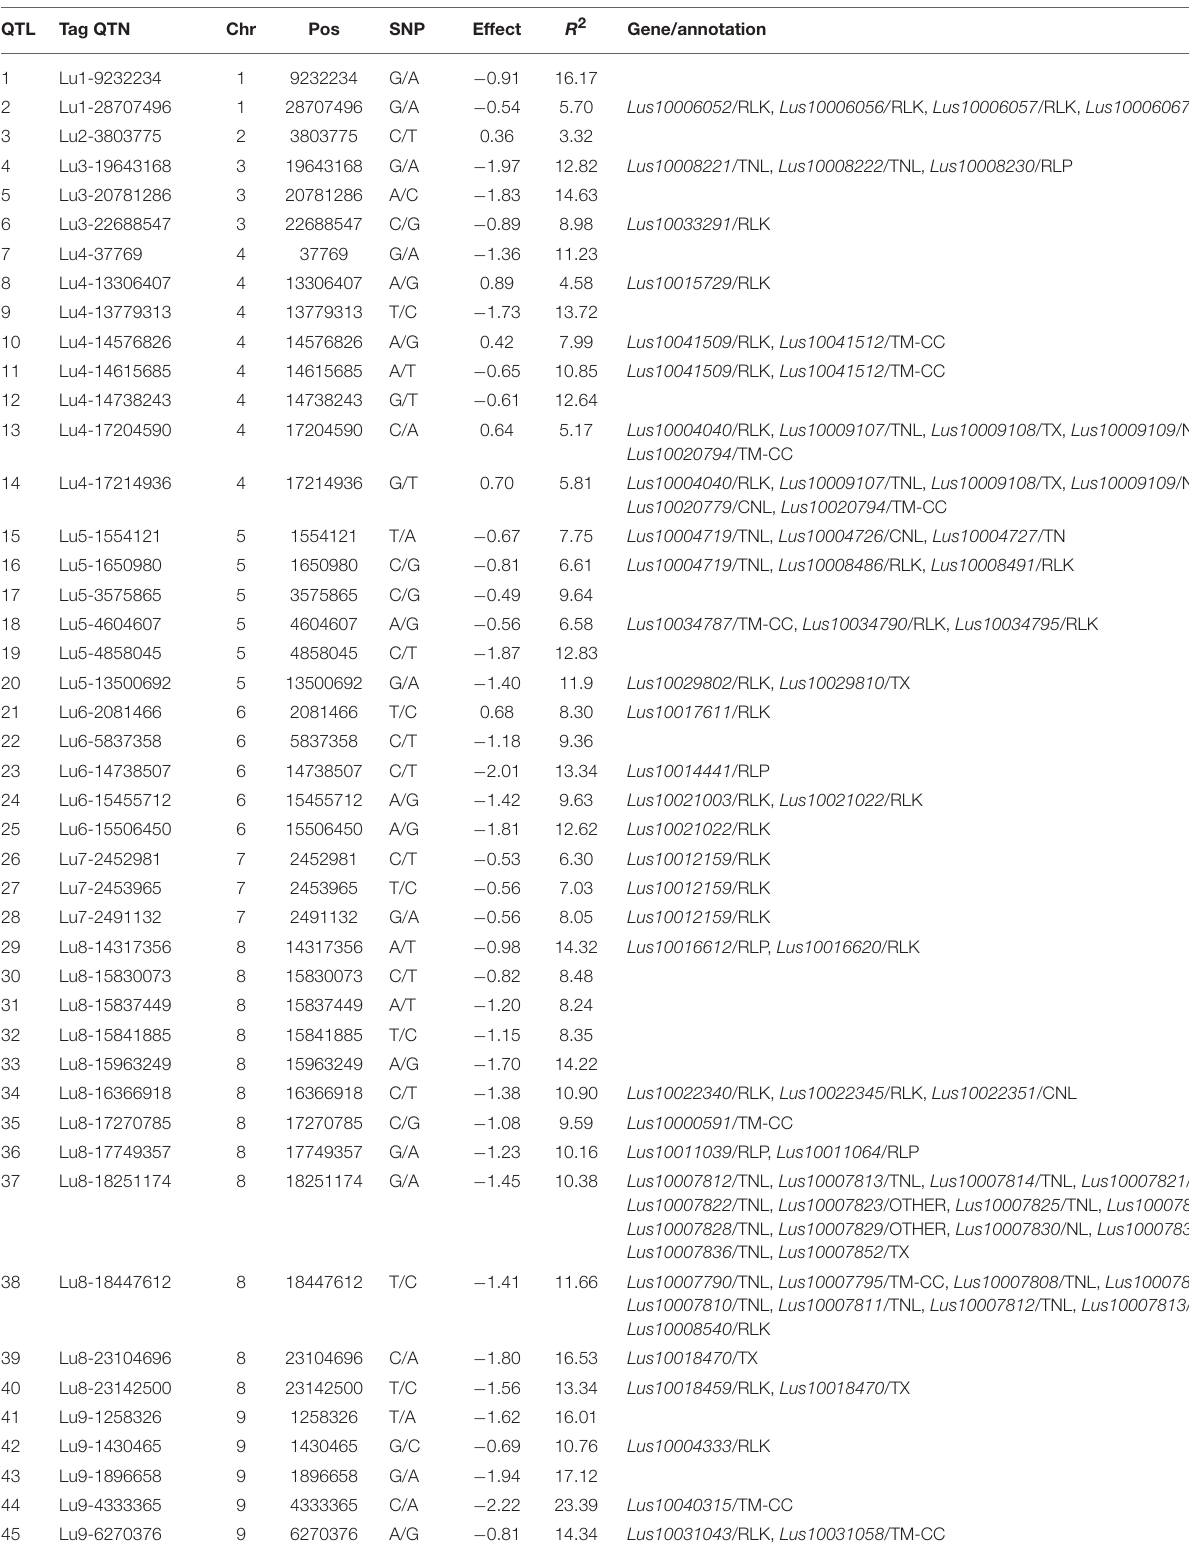
TABLE 8 | Stable and large-effect QTL associated with pasmo